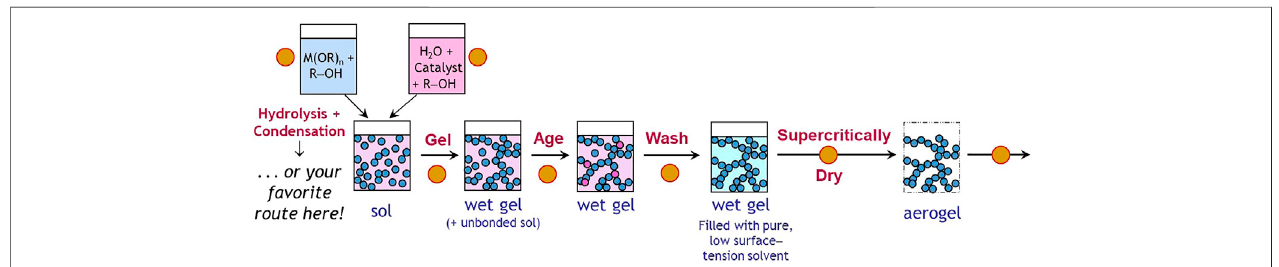
FIGURE 3 | Illustration of the sol – gel synthetic route to aerogels, including the many points ( C ) during the synthetic and processing steps at which new physicochemical functionality can be introduced.